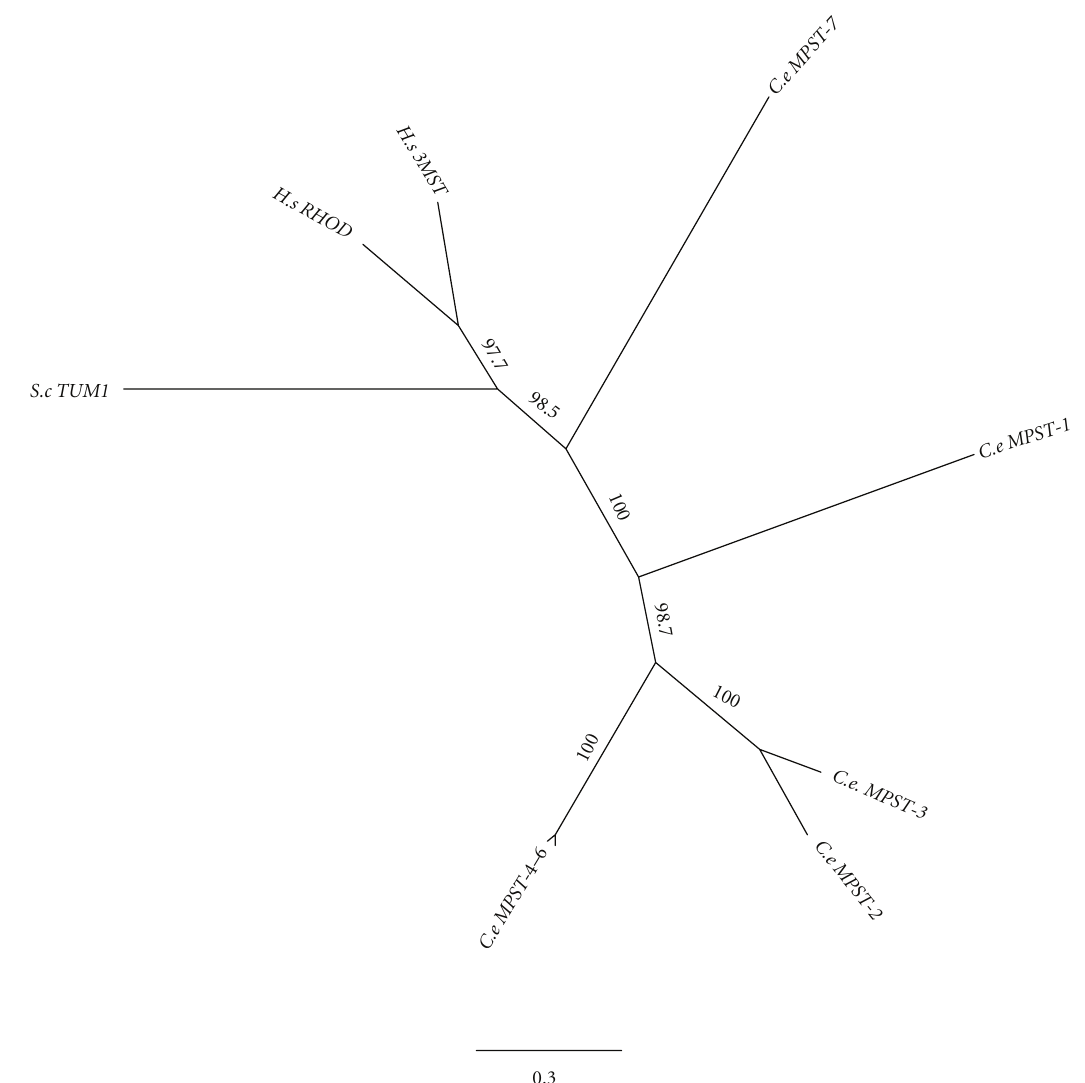
Figure 4: Phylogenetic tree analysis of 3-mercaptopyruvate sulfurtransferase (3MST/MPST). See Figure 2 for details on the phylogenetic